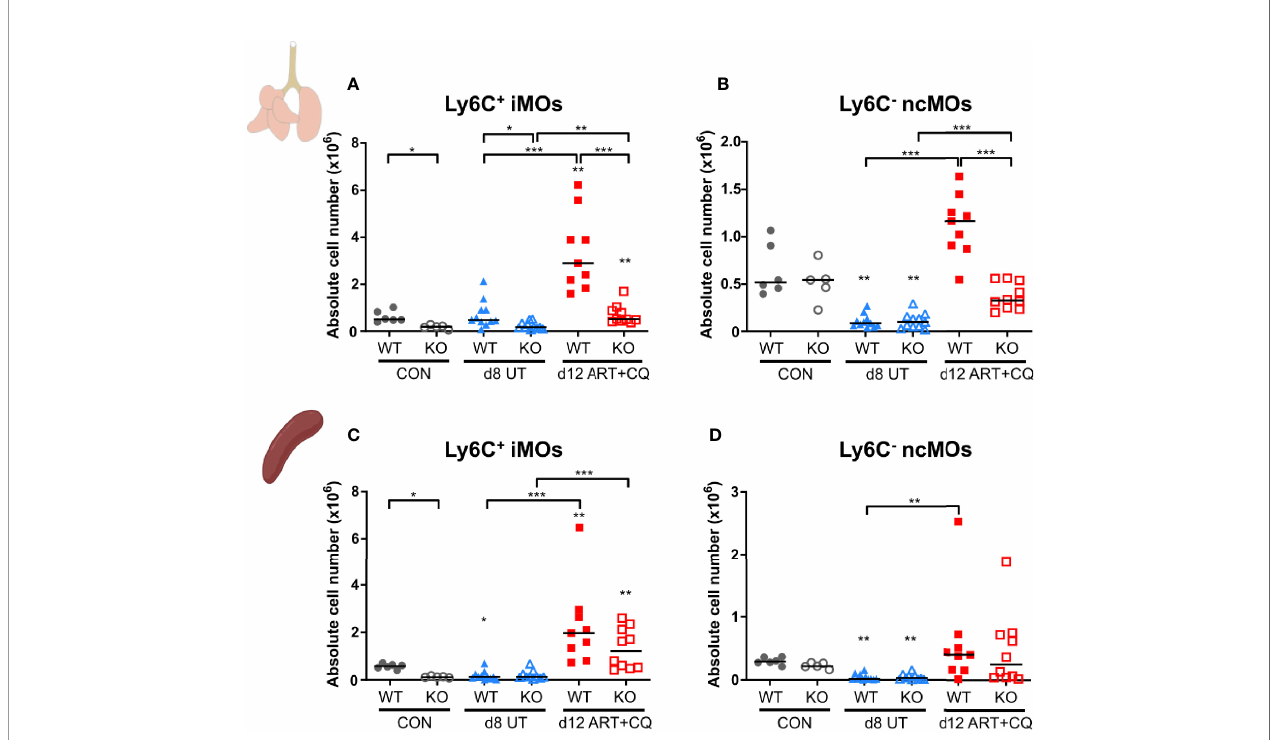
FIGURE 7 | The CCR2 knock-out resulted in less monocytes present in the lungs, but not in the spleen. CCR2 WT and CCR2 KO C57BL/6 mice were infected with Pb NK65. Mice were injected daily from 8 until 12 days p.i. with 10 mg/kg ART + 30 mg/kg CQ. Mice were dissected at the indicated days p.i. Leukocytes were isolated from the lungs according to protocol 2 and from the spleen and fl ow cytometry was performed. (A – D) The absolute numbers of Ly6C + iMOs (A, C) and Ly6C − ncMOs (B, D) present in the lungs (A, B) and spleen (C, D) were calculated. Compilation of two experiments. Each symbol represents data of an individual mouse. n=6 for CON CCR2 WT, n=5 for CON CCR2 KO, n=11 for UT CCR2 WT, n=11 for UT CCR2 KO, n=9 for ART+CQ CCR2 WT, n=10 for ART+CQ CCR2